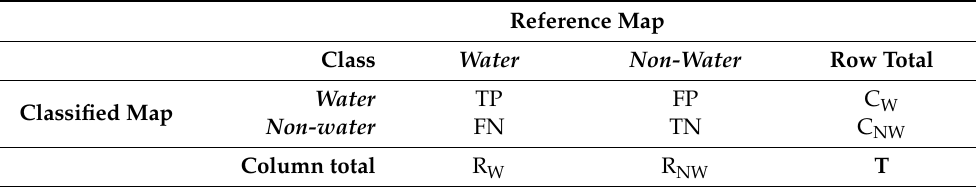
Table 4. Example of a confusion matrix for water pixel classification. (C W and C NW represent the total number of pixels respectively corresponding to water and non-water classes in the classified map, while R W and R NW represent the total number of pixels respectively corresponding to water and non-water classes in the reference map. T is the total number of pixels in the image.) Reference Map Class Water Non-Water Row Total Water TP FP C W Classified Map Non-water FN TN C NW Column total R W R NW